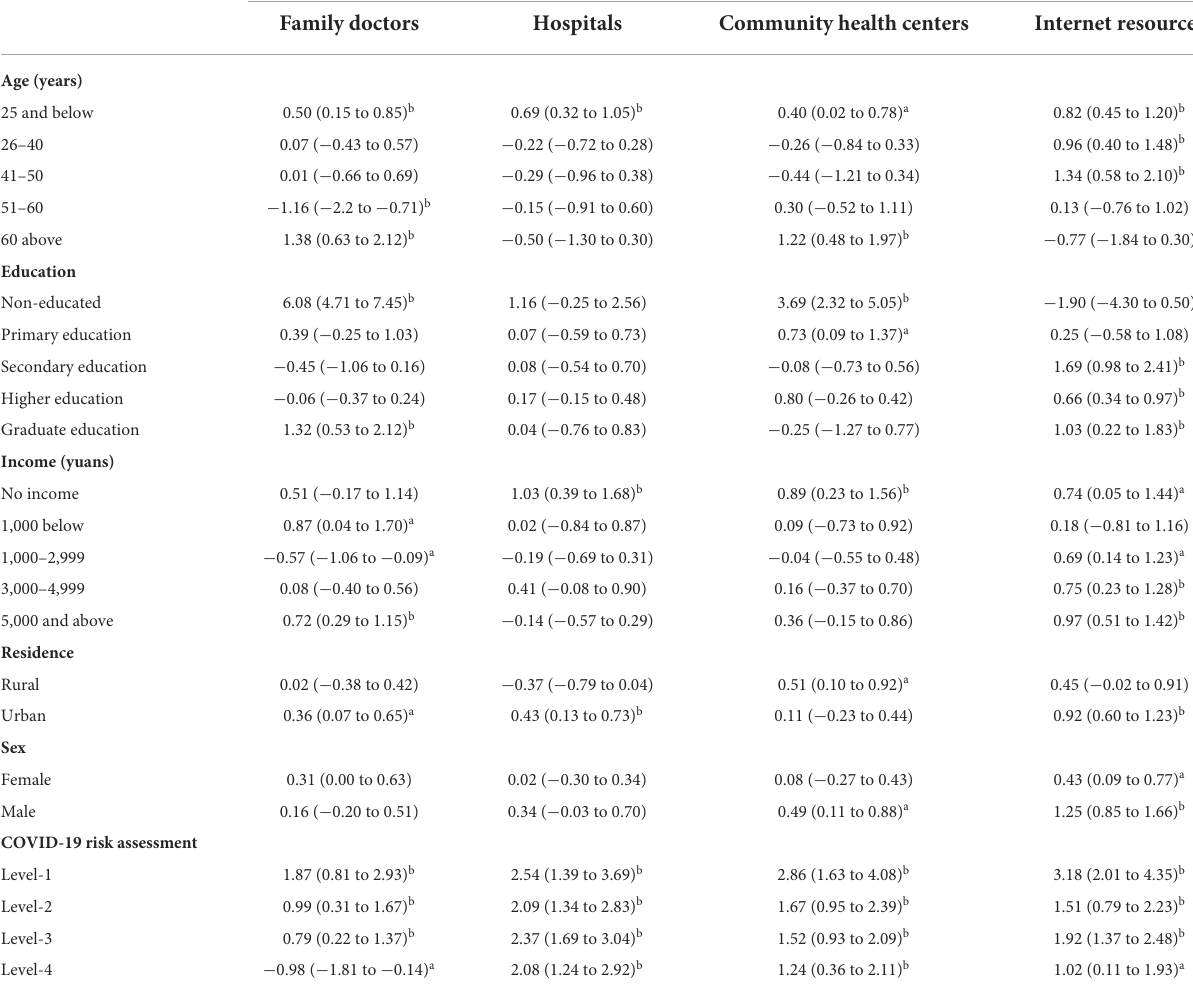
TABLE 2 The association between different information sources and COVID-19 preventive behaviors of different publics. Factors Information sources [Mean difference (95%CI)] Family doctors Hospitals Community health